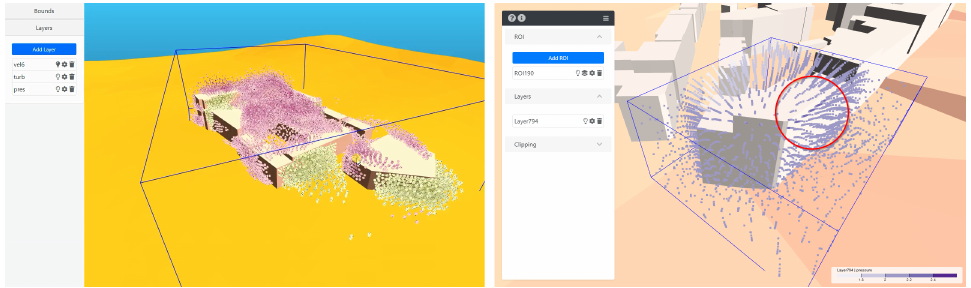
Figure 1. Visualization of CFD simulation attributes to indicate/exclude locations for/from further investigation. ( Left ) Color encoded locations in red hue indicate high turbulence areas which should be excluded from further analysis. Color encoded locations in yellow hue indicate areas of high wind pressure on building façades, and further analysis is recommended. ( Right ) Color encoded locations in purple hue indicate areas with high wind pressure on buildings near eaves